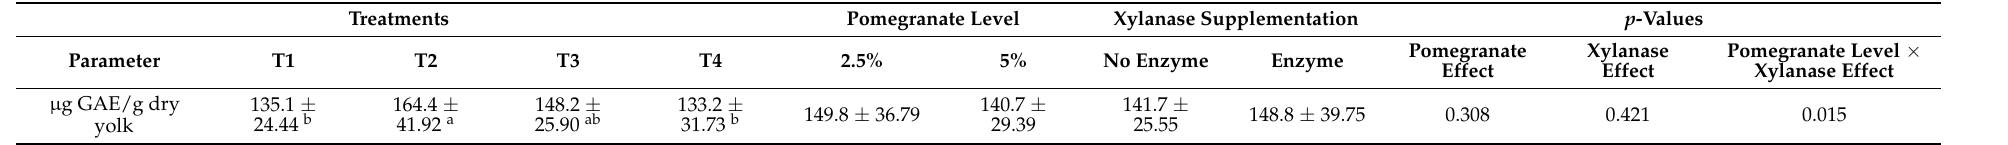
Table 6. Effects of two levels of pomegranate peel byproduct with or without xylanase on egg yolk total phenolic content. T1: 2.5% PPB; T2: 2.5% and xylanase;